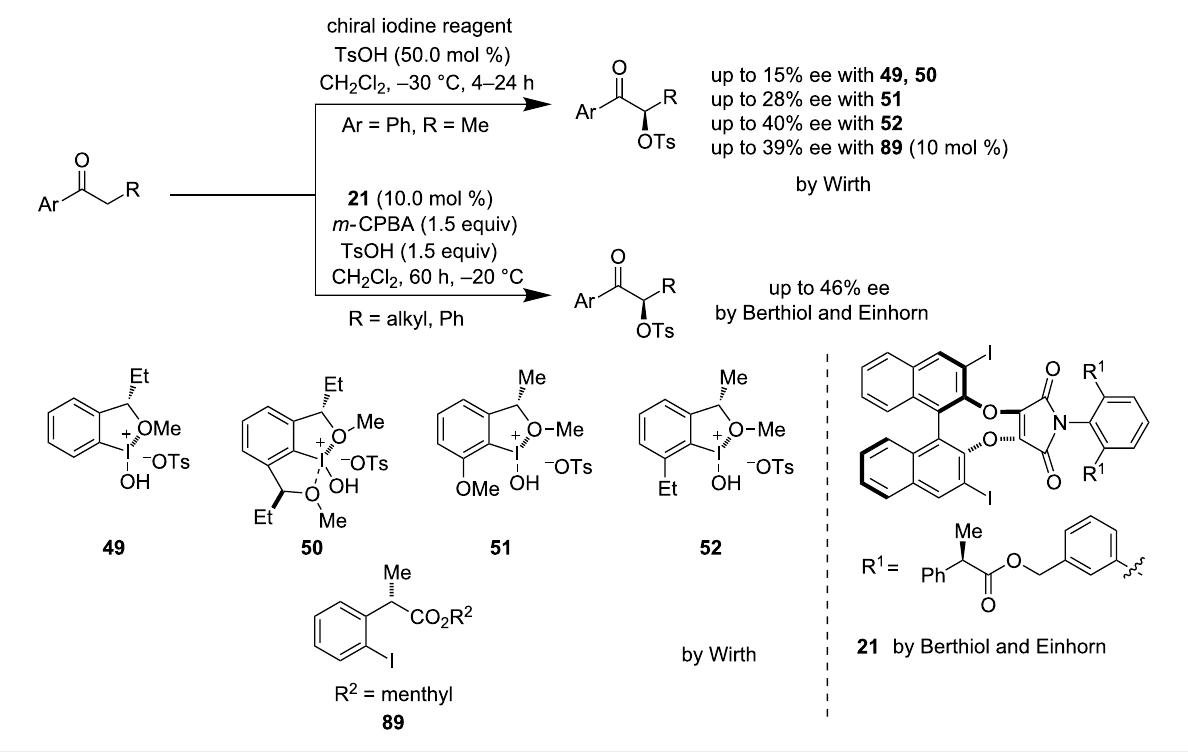
Scheme 18: Asymmetric α -oxytosylation of carbonyls.